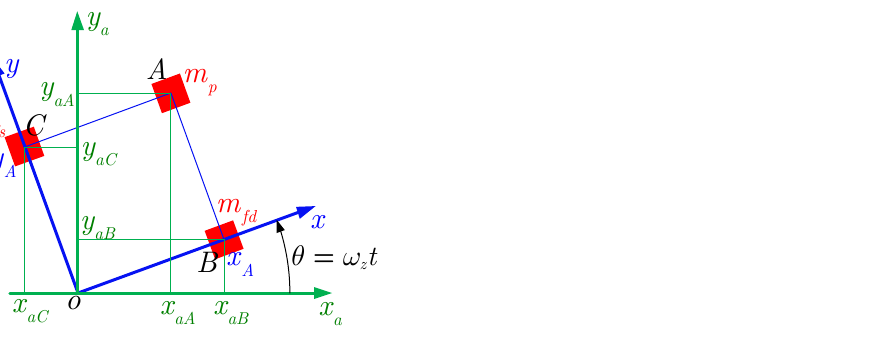
Figure 2. The relation between the displacements of the gyroscope coordinate system and the inertial coordinate